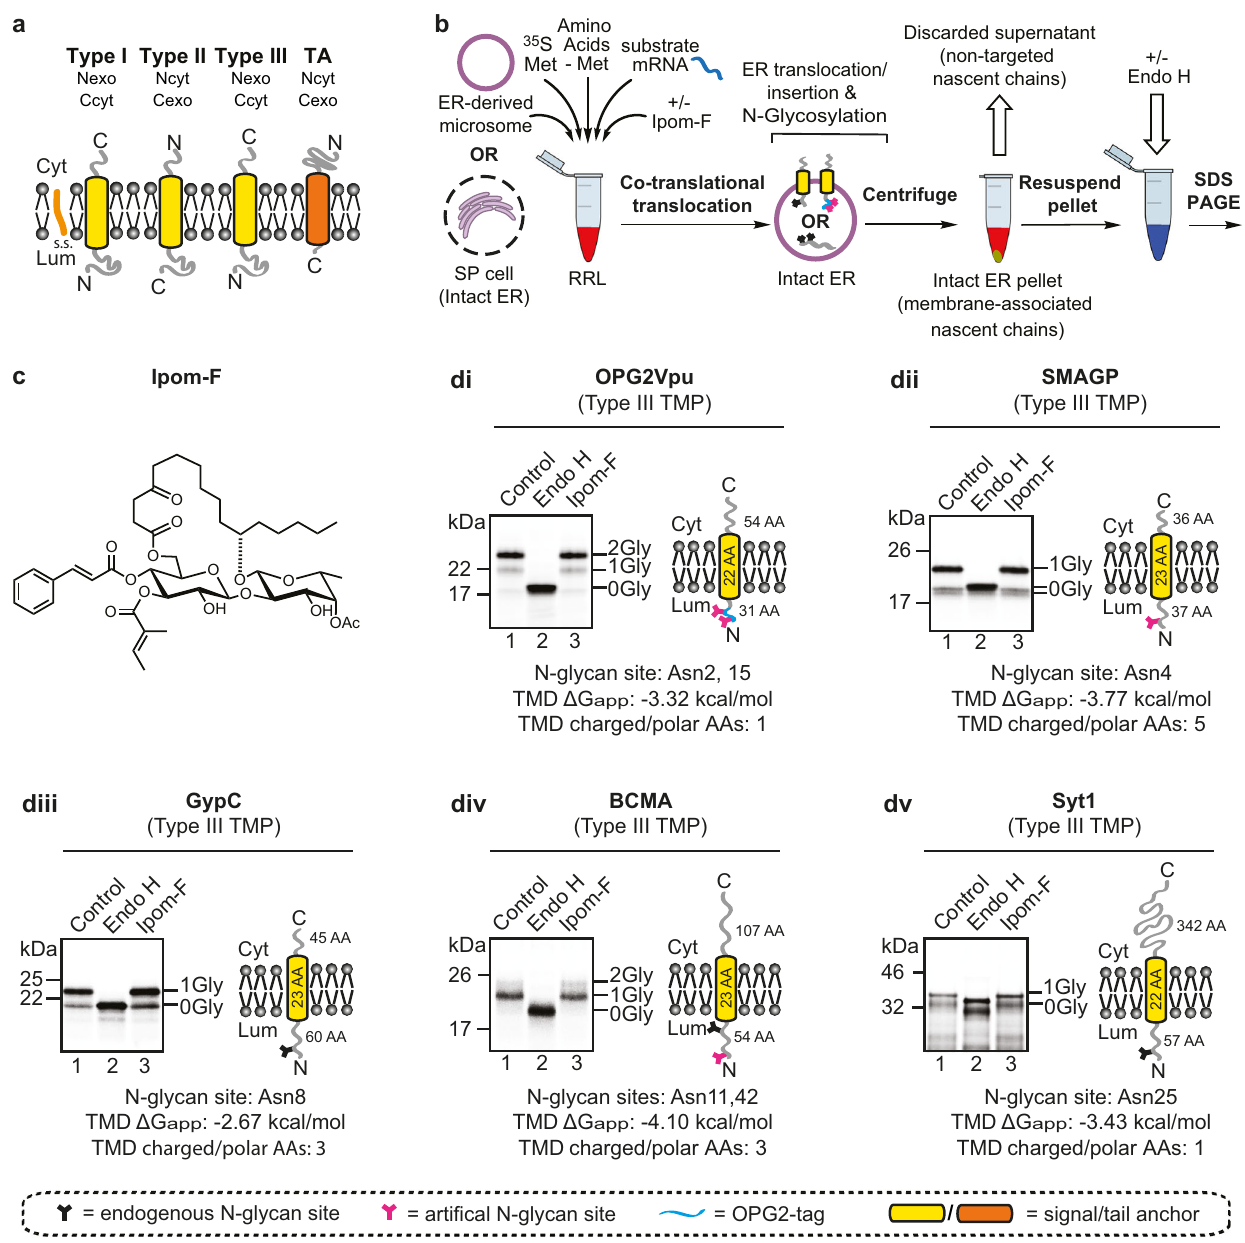
Fig. 1 Type III TMPs are resistant to Ipom-F. a Schematics of type I, type II, type III and tail-anchored (TA) proteins showing their topologies in the ER membrane. b Outline of the in vitro assay where either canine pancreatic microsomes or semi-permeabilised HeLa cells were used as sources of ER membrane; following translation, membrane inserted radiolabelled precursor proteins are recovered by centrifugation and analysed by SDS-PAGE and phosphorimaging. The N-glycosylation of lumenal domains, con fi rmed by treatment with endoglycosidase H (Endo H), indicates successful membrane translocation/insertion. c The chemical structure of ipomoeassin F (Ipom-F), a potent and selective inhibitor of Sec61-mediated protein translocation 1 . d Model type III TMPs used in this study were synthesised as outlined in ( b ) using canine pancreatic microsomes: ( di ) an N-terminally OPG2-tagged form of the HIV protein Vpu (OPG2Vpu), ( dii ) small cell adhesion glycoprotein containing an arti fi cial N-glycosylation site (SMAGP), ( diii ) glycophorin C (GypC), ( div ) tumour necrosis factor receptor superfamily member 17 containing an arti fi cial N-glycosylation site (BCMA) and ( dv ) synaptotagmin 1 (Syt1). Variably N-glycosylated (XGly) and non-glycosylated (0Gly) species are indicated, having been con fi rmed using Endo H (lane 2). Other symbols are: AAs, amino acid residues; Cyt, cytosol; Lum, ER lumen; RRL, rabbit reticulocyte lysate; s.s., N-terminal signal sequence. Estimated hydrophobicity values ( 4 Gapp) 42 of predicted transmembrane domains (TMDs) in kcal /mol were calculated using: http://dgpred.cbr.su.se/ (full protein scan option). Charged amino acid residues, D, E, H, K, R; polar amino acid residues, N, Q, S, T, Y.